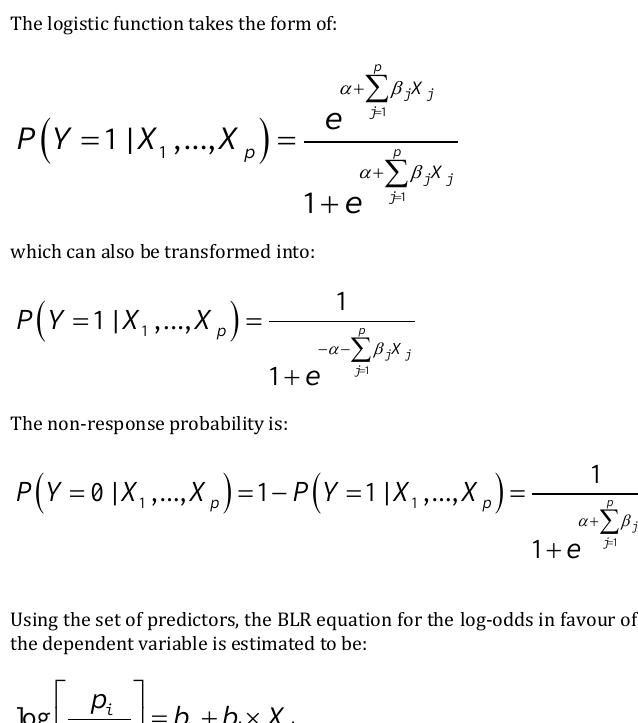
Table 3: Results of the binary logistic regression model